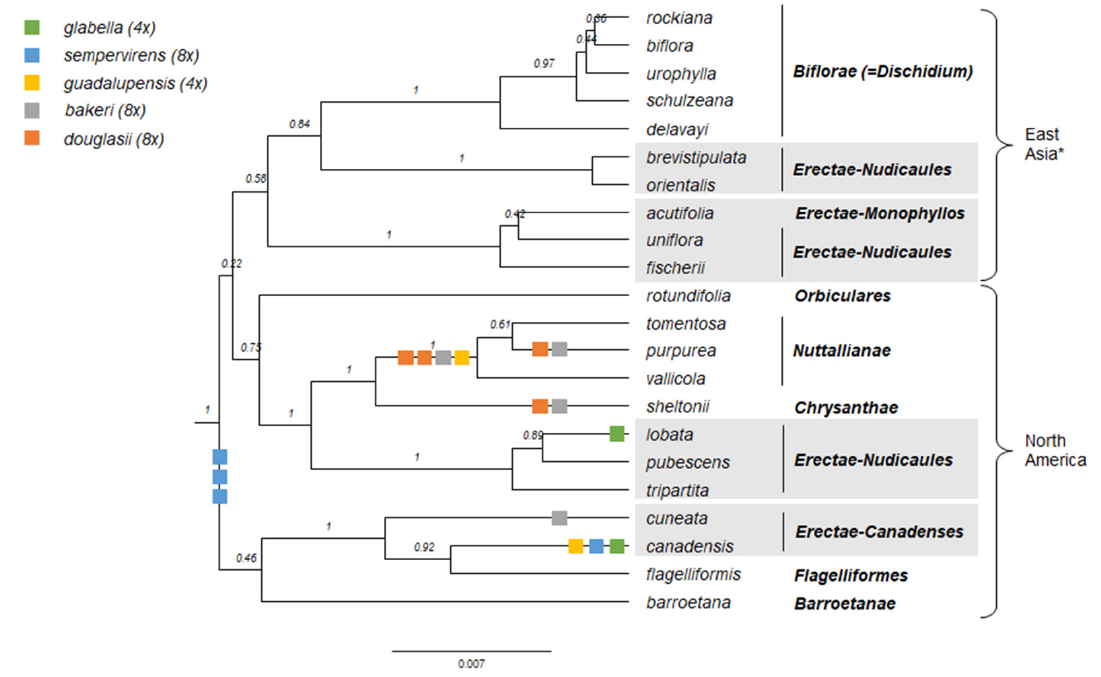
Figure 13. Ultrametric phylogeny of diploid taxa of Viola sect. Chamaemelanium , showing the basal irresolution among otherwise well-supported infrasectional lineages and the non-monophyly of Becker’s greges at both the diploid and allopolyploid level. Outgroups have been trimmed. The analysis was performed on a concatenated matrix of four loci ( GPI , ITS , NRPD2a , trnL-trnF ). The squares indicated on branches show the approximate phylogenetic placement of homoeologs of five North American allopolyploids [60], V. bakeri (8 x ), V. douglasii (8 x ), V. glabella (4 x ), and V. guadalupen- sis (4 x ). Branch support is given as posterior probabilities. * Viola biflora has a circumboreal distribu-